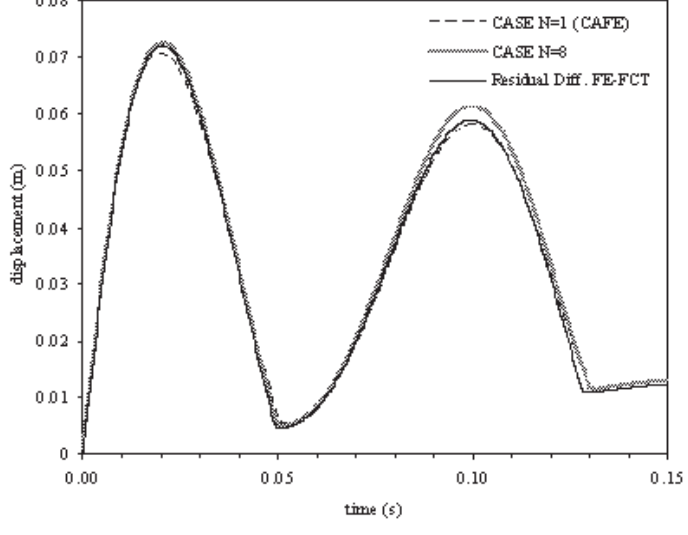
Fig. 11. Results for the displacement of m 1 using 161 fluid DOF.